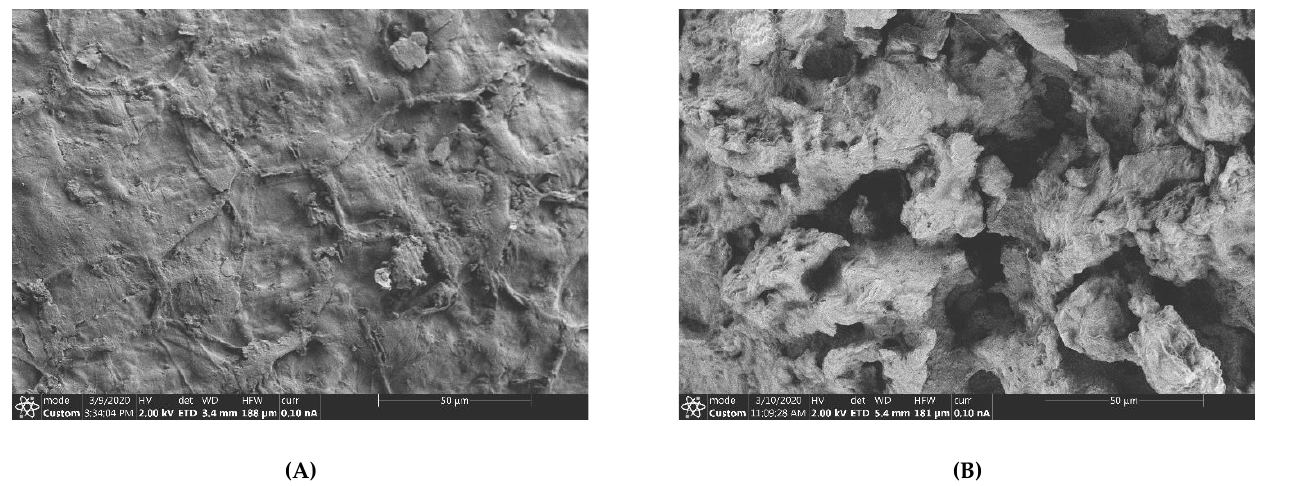
Figure 2. Representative SEM micrographs showing the effect of enzymatic pretreatment (1.7%, 40 °C, pH = 4.5 and 5 h) on the pomegranate seed microstructure ( A ) un-pretreated pomegranate seed, ( B ) enzyme pretreated pomegranate seed.